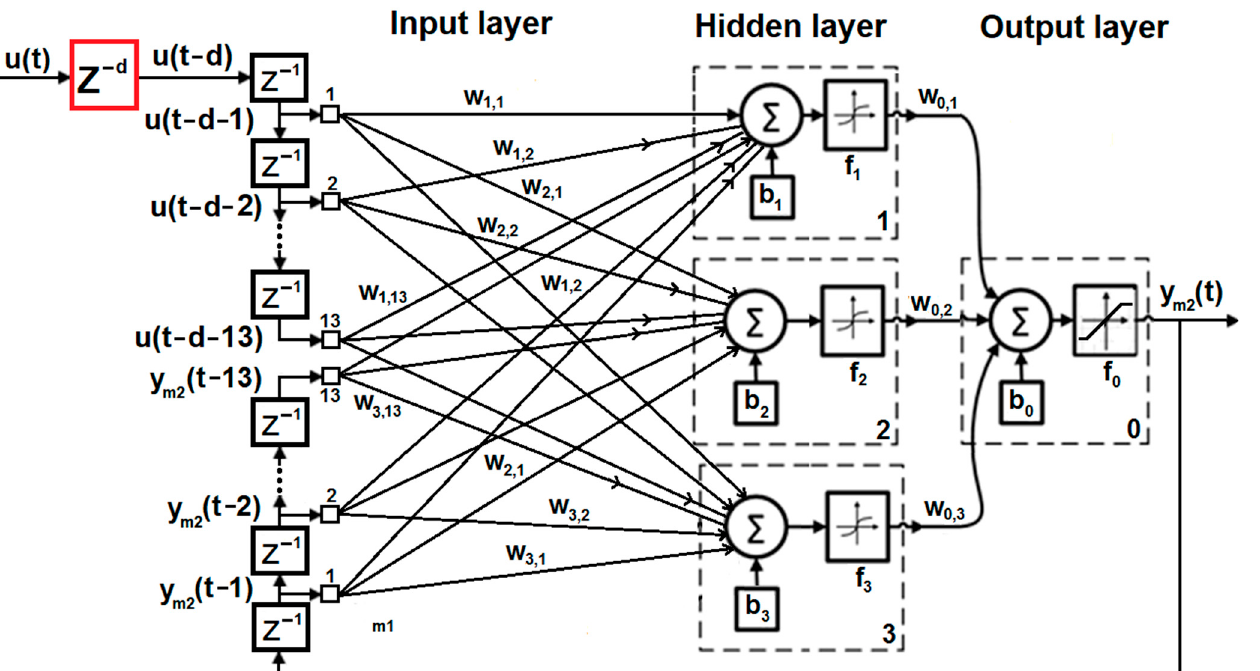
Figure 4. Architecture of the TD-NARX-ANN-based model designed. The difference between the architecture of these models lies in the TD-NARX-ANN-based model has the time delay block Z − d highlighted in red line.